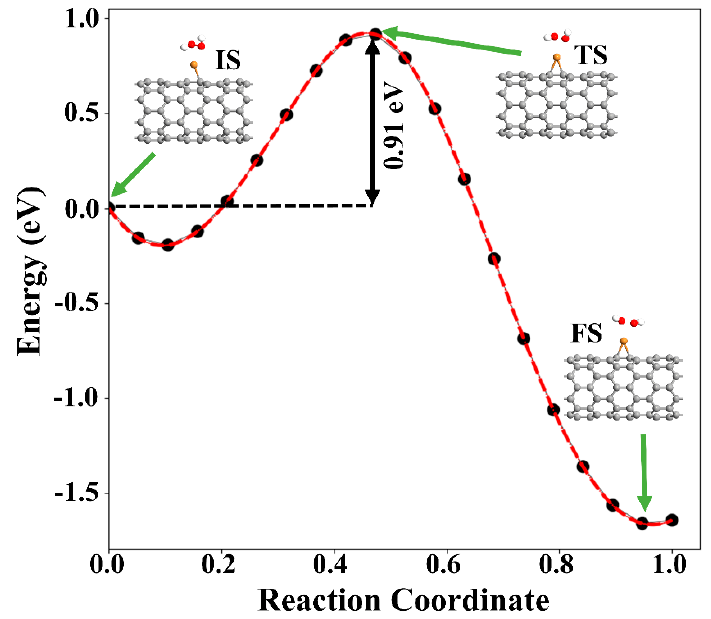
Figure 9. MEP of H 2 O 2 decomposition hydroxyl radicals (OH) on the Cu-SWCNT. The initial state (IS), transition state (TS), and final state (FS) are shown in the inset. The green arrows show the initial, transition, and final states. Table 3. The calculated adsorption energy (E ad ), binding distance (D), which is the distance between H 2 O 2 molecule and the metal in the metal ‐ decorated CNT structure or the shortest distance between the H 2 O 2 molecule and the nanotube in the pristine CNT structure, magnetic moment (m), charge transfer (Q), energy bandgap (E g ), and recovery time ( τ ) at T = 298 and 398 K under UV. The negative values of charge indicate a charge transfer from the molecule to the nanotube.